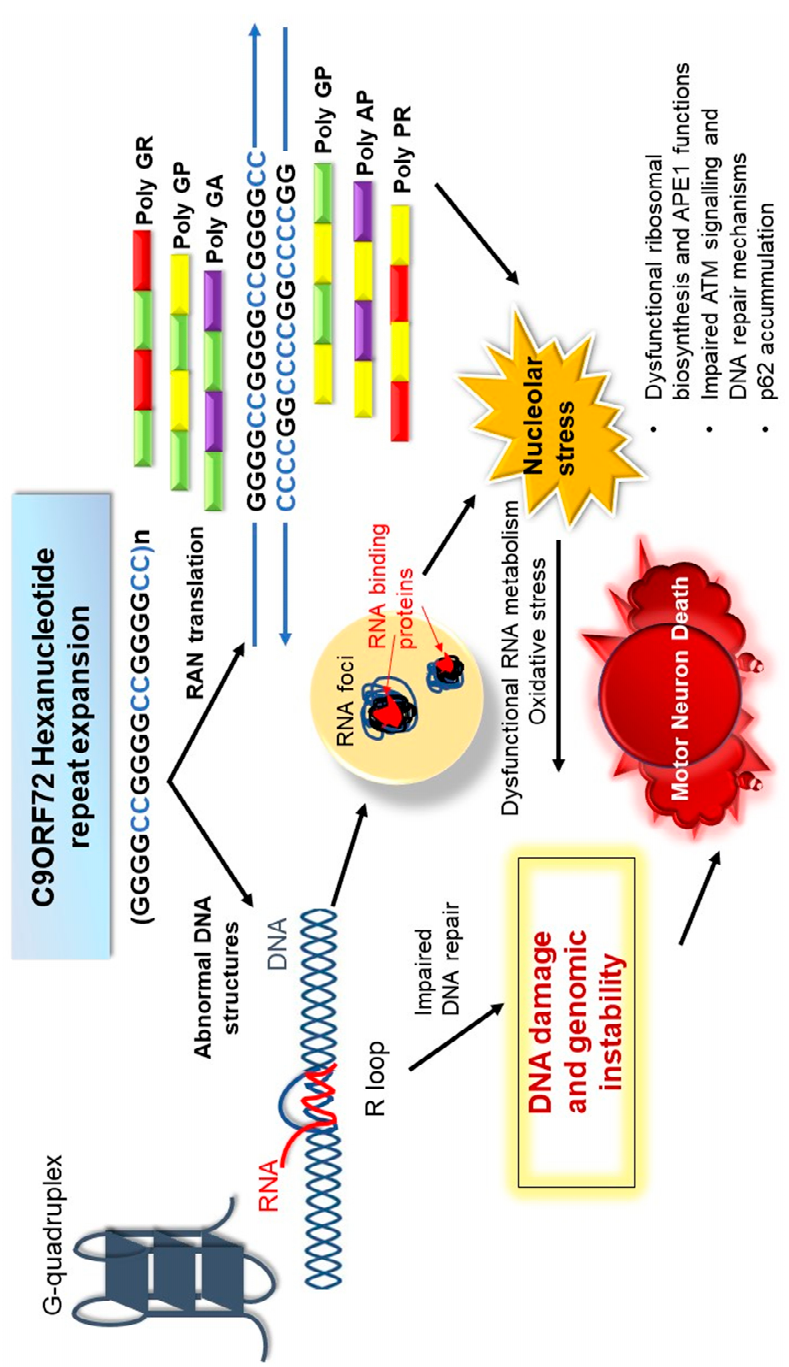
Figure 2. Mechanisms of amyotrophic lateral sclerosis (ALS) pathogenesis induced by the chromosome 9 open reading frame 72 ( C9orf72 ) repeat expansion. The C9orf72 repeat expansion forms abnormal nucleic acid structures, including R ‐ loops, which perturb DNA repair processes involving ATM, and probably other mechanisms. The expanded RNA forms foci and sequesters RNA binding proteins, leading to dysfunction in RNA processing. The C9orf72 DPRs, produced by RAN translation, also accumulate in the nucleolus, leading to perturbations in nucleolar function, including DNA repair processes, ribosomal biogenesis, and APE ‐ dependent mechanisms (including oxidative stress). They also impair DNA repair by p62 ‐ dependent mechanisms. Together, these events result in the accumulation of DNA damage, genome instability, and motor neuron death.